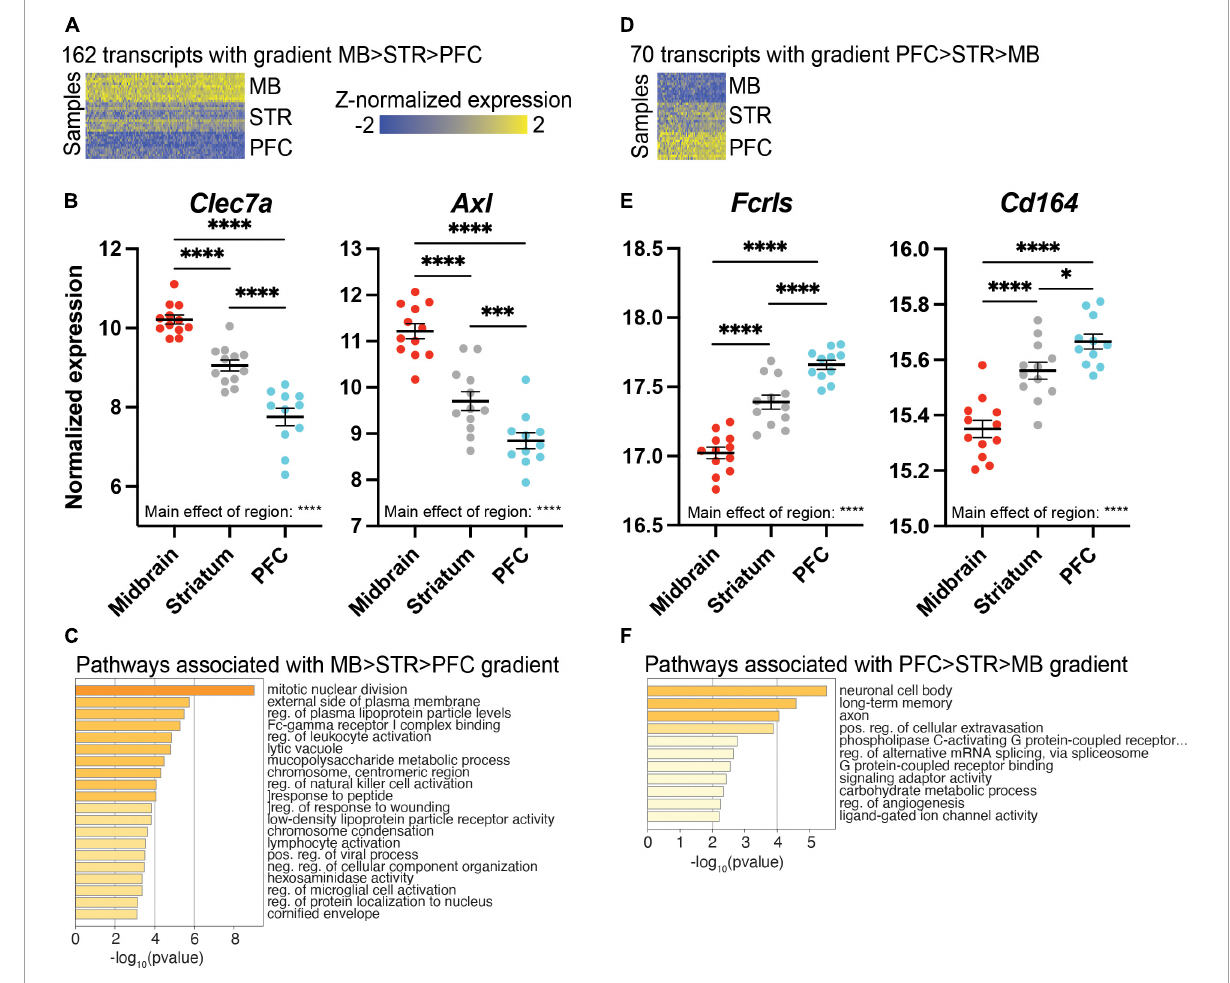
FIGURE5 Differentially expressed (DE) transcripts exhibiting a gradient of expression across brain regions. (A) Heatmap of 162 DE transcripts with highest expression in the midbrain (MB), intermediate expression in the striatum (STR), and lowest expression in the prefrontal cortex (PFC). DE transcripts are plotted on the x-axis and individual subject samples on the y-axis. (B) Clec7a and Axl exhibit a gradient of expression of MB > STR > PFC. (C) Top pathways represented by transcripts exhibiting a gradient of expression of MB > STR > PFC. (D) Heatmap of 70 transcripts exhibiting highest expression in the PFC, intermediate expression in STR, and lowest expression in MB. (E) Fcrls and Cd164 exhibit a gradient of expression of PFC > STR > MB. (F) Top pathways represented by transcripts exhibiting a gradient of expression of PFC > STR > MB. ∗ , p < 0.05; ∗∗∗ , p < 0.001; ∗∗∗∗ , p <